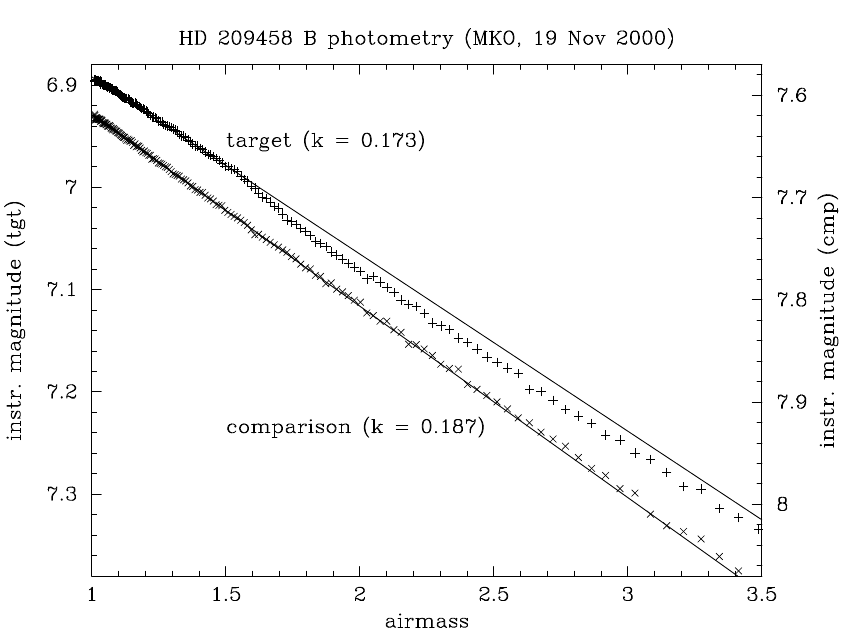
Fig. 8. Instrumental magnitude versus airmass plots for the target and comparison stars for observations made on 19 November 2000. The straight lines correspond to linear airmass